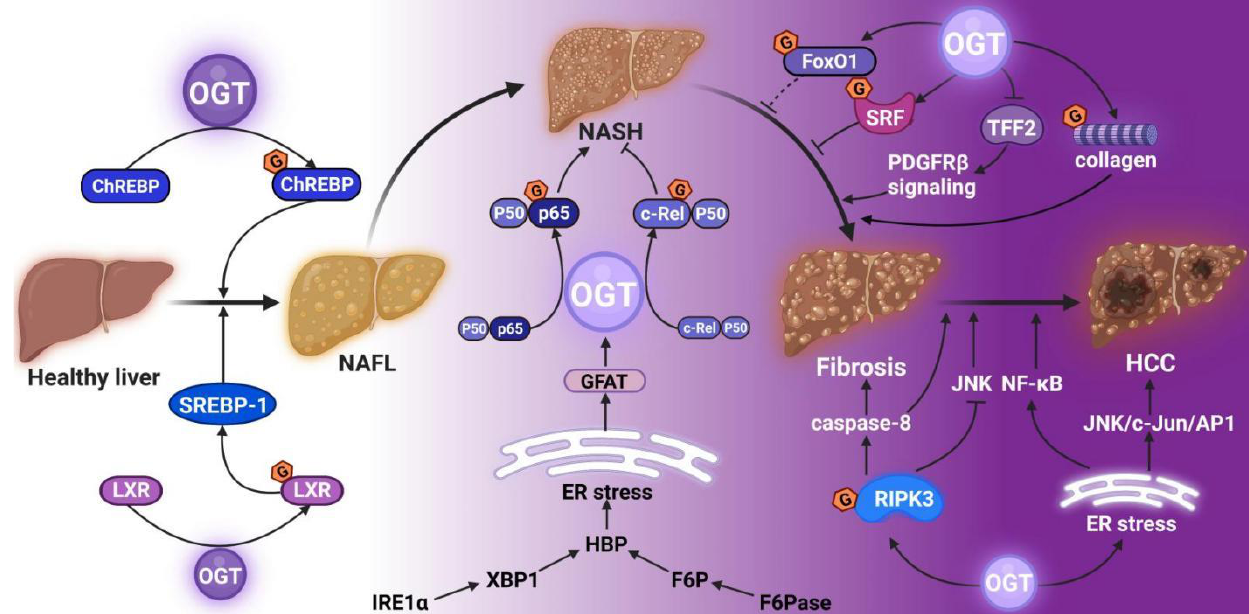
Figure 3. O-GlcNAcylation and NAFL-NASH-liver fibrosis-hepatoma tetralogy. The O-GlcNAcylation of the LXR, the ChREBP, and SREBP-1 promoted NAFL formation. O-GlcNAcylated NF- κ B subunit